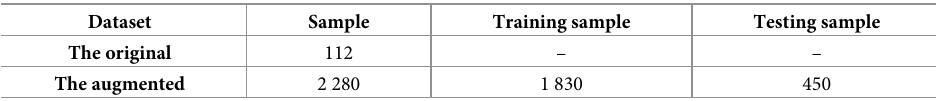
Table 1. An overview of the used data of SPECT